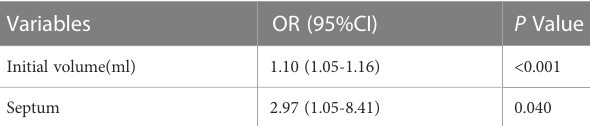
TABLE 3 Multivariate logistic regression analysis of predictors of residue of PCTNs after